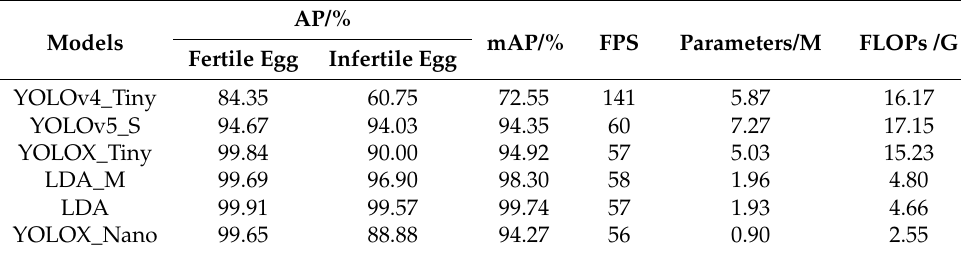
Table 8. Comparison of model performance results of different feature extraction